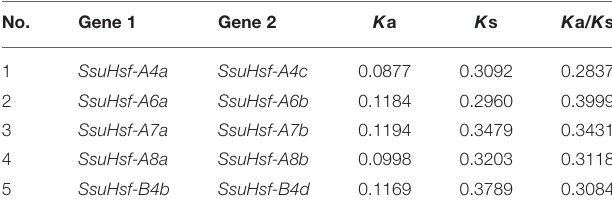
TABLE 3 | Divergence between paralogous SsuHsf gene pairs.